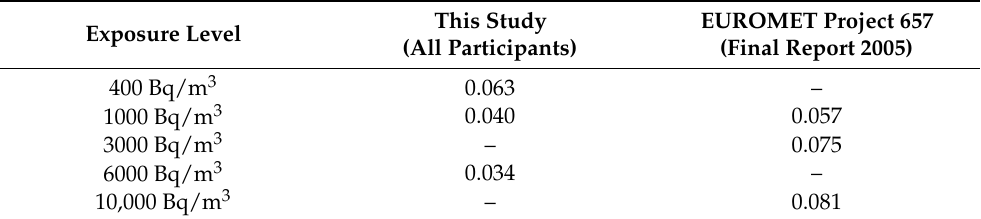
Table 6. Expanded variation intervals for the measurements of the radon activity concentration obtained in this study and the EUROMET Project 657.